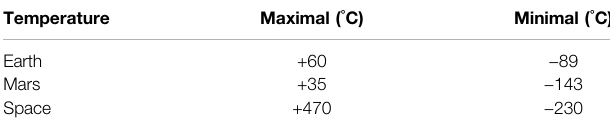
TABLE 1 | Range of temperatures on Earth and in space